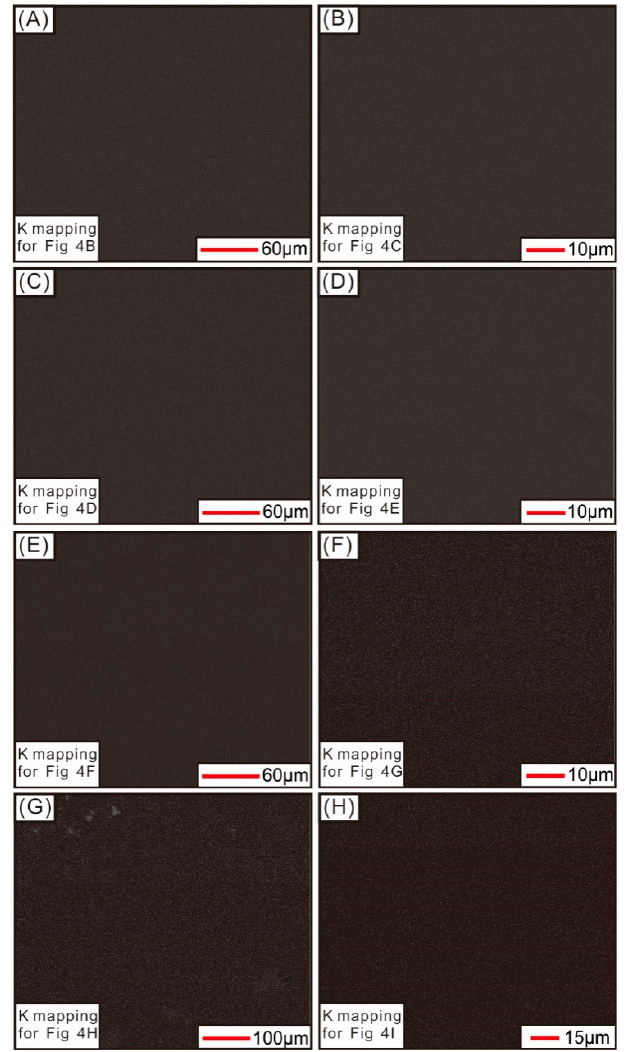
Figure 5. SEM-EDS elemental mapping of potassium (K) for pyrites in Figure 4B–I ( A – H ). The mapping results show that the K content of the pyrites is below the detection limit of the instrument, supporting the absence of K-rich inclusion in the pyrites.